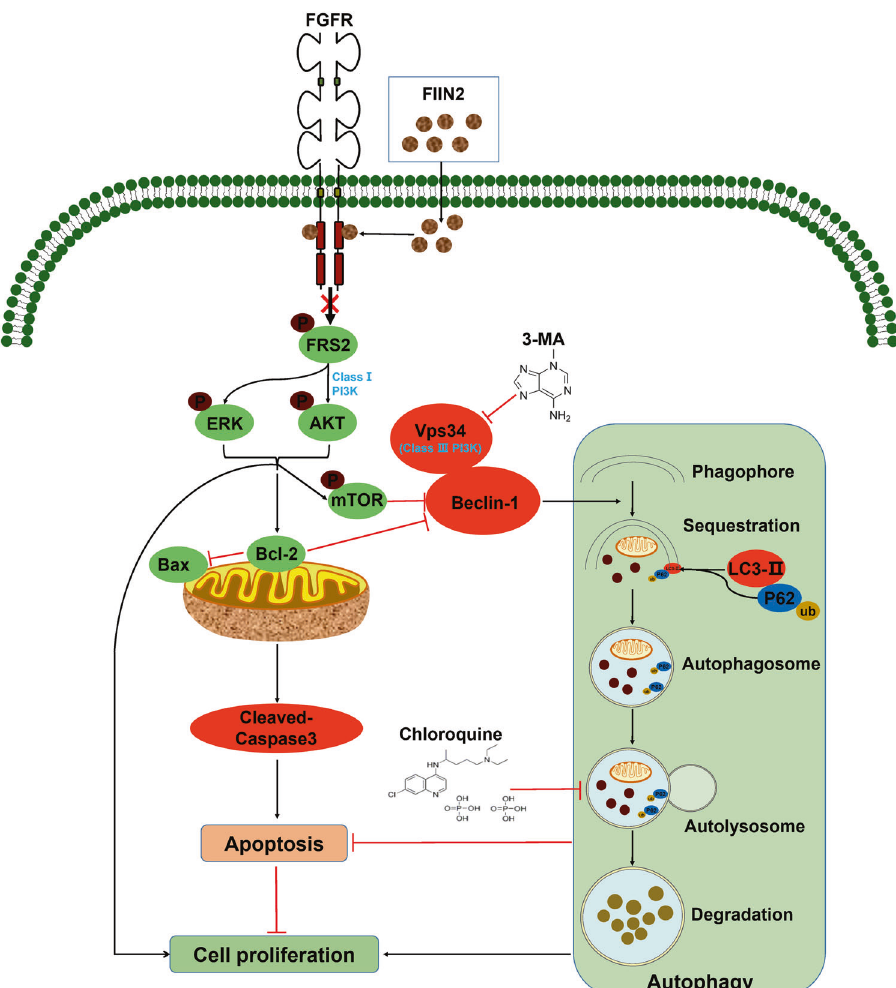
Fig. 7 The potential regulatory mechanism of inhibiting autophagy to enhance the cytotoxicity of FIIN-2 on A549 and A549/DDP cells. FIIN-2 can inhibit proliferation and induce mitochondria-mediated apoptosis in A549 and A549/DDP cells by inhibiting FRS2 and its downstream AKT and ERK pathways. FIIN-2 can also induce protective autophagy by mTOR inhibition and further activation of the class III PI3K pathway (Vps34-Beclin-1 complex). Moreover, cotreatment of FIIN-2 with the early stage or late-stage autophagy inhibitors 3-MA or CQ enhanced the cytotoxicity of FIIN-2 by inhibiting proliferation and inducing apoptosis in A549 and A549/DDP